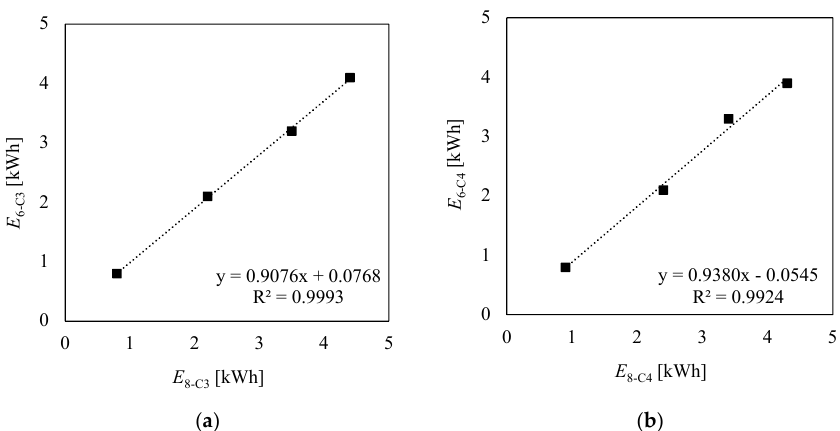
Figure 9. Regressed function between daily electricity consumption of ( a ) 6-C3 and 8-C3 and ( b ) 6-C4 and 8-C4 at the baseline stage.